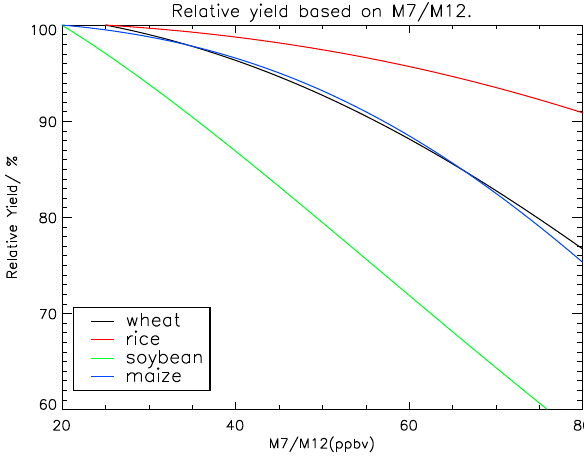
Fig. 15. Relative yield as a function of M7/M12 for wheat, rice, maize and soybean. The equations for these functions are shown in Table